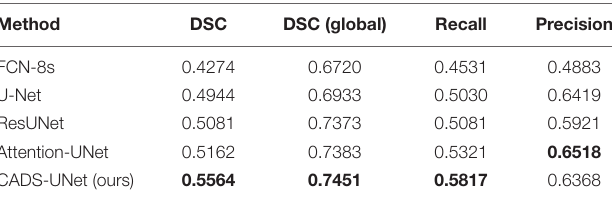
TABLE 1 | Comparison with state-of-the-art methods on the ATLAS